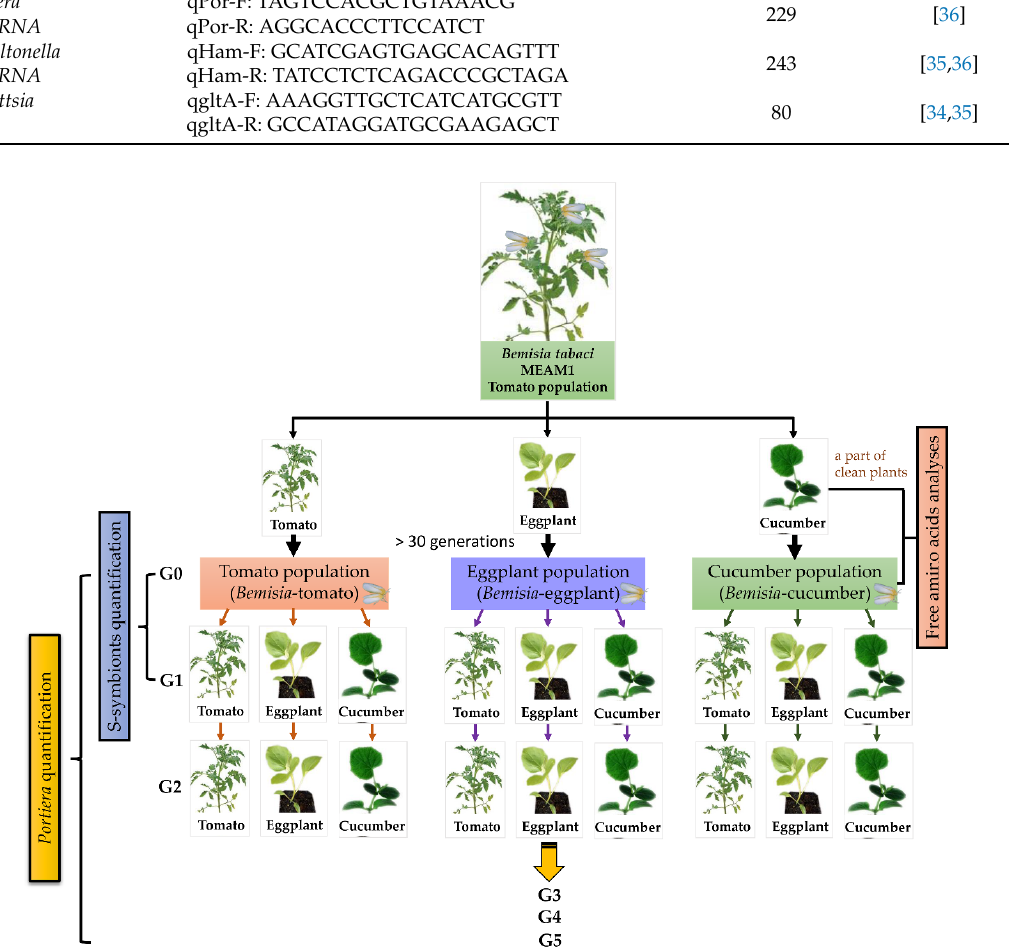
Figure 1. Schematic diagram of the plant switch experiments designed in this study. MEAM1: Middle East-Asia Minor 1.